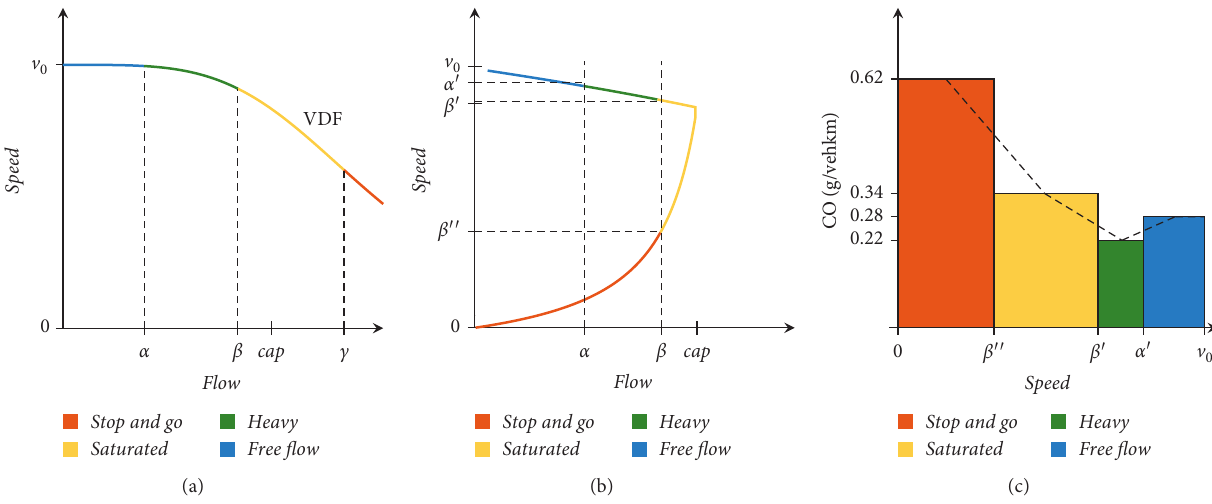
Figure 4: (a) Volume to capacity thresholds and VDF (flow < α : Free flow , α ≤ flow < β : Heavy , β ≤ flow < c : Saturated , and flow ≥ c : Stop and go ). (b) Hyperbolic linear fundamental diagram and derivation of speed thresholds [19] (speed > α ′ : Free flow , α ′ ≥ speed > β ′ : Heavy , β ′ ≥ speed > β ″ : Saturated , and speed ≤ β ″ : Stop and go ). (c) CO emission factor as a discrete (bars) and as a continuous (dashed line) function of average